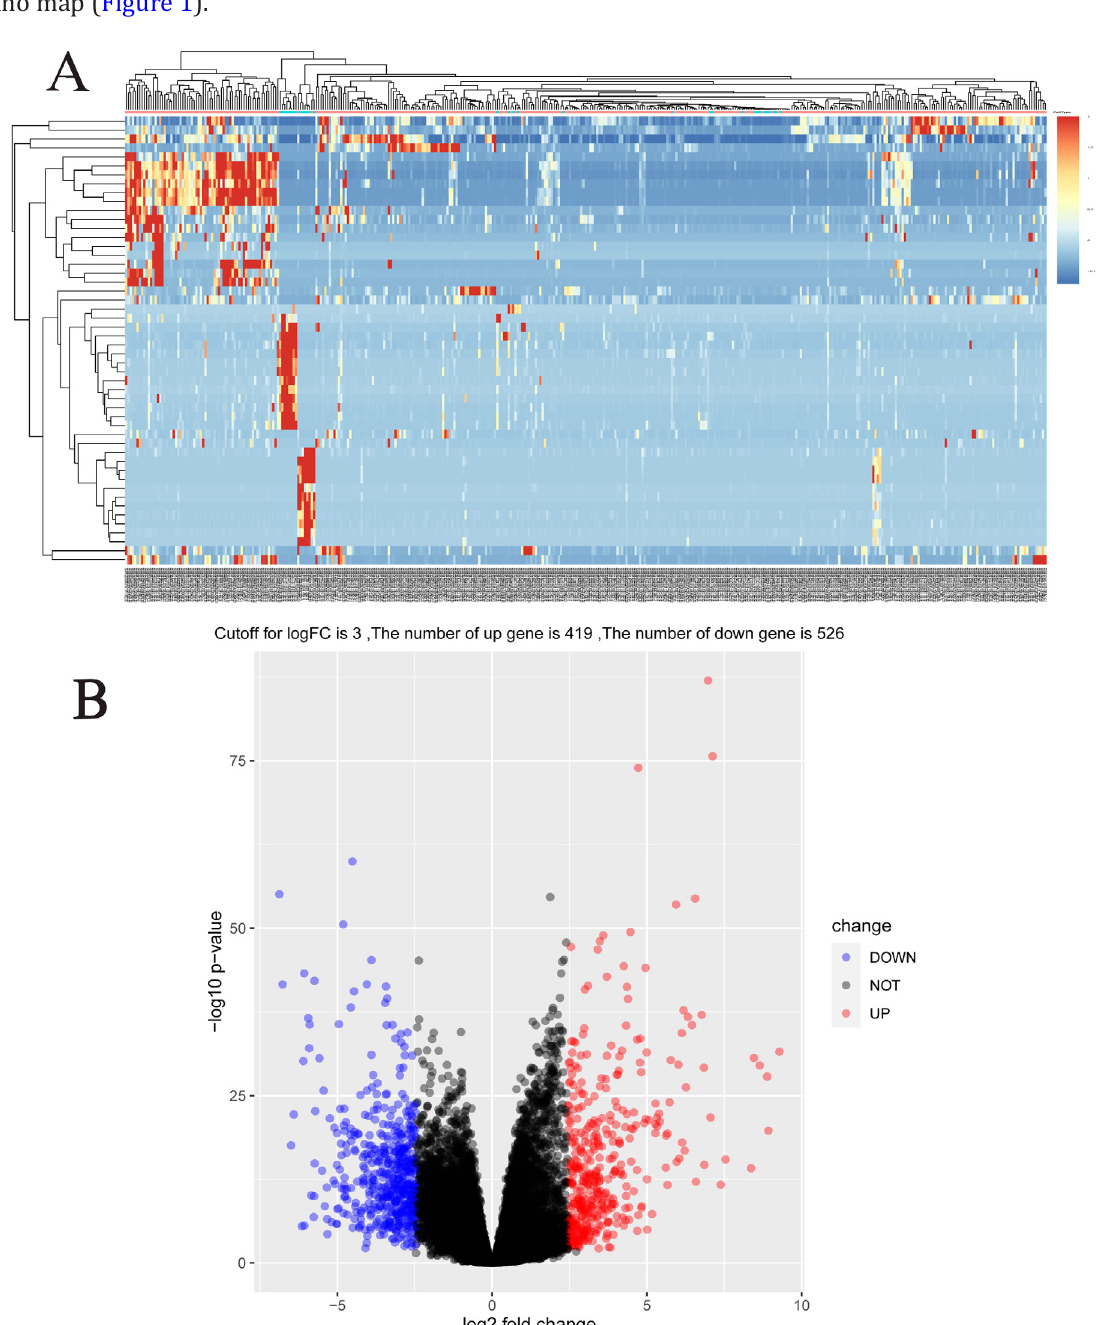
Figure 1. Heat map and volcano map of mRNA differential genes in gastric cancer. (A) Heat map of 947 mRNA differential genes in gastric cancer, and the top 50 most representative genes were selected to draw the heat map; (B) volcano map of 947 genes obtained at a cutoff value of 3, of which 419 were upregulated and 526